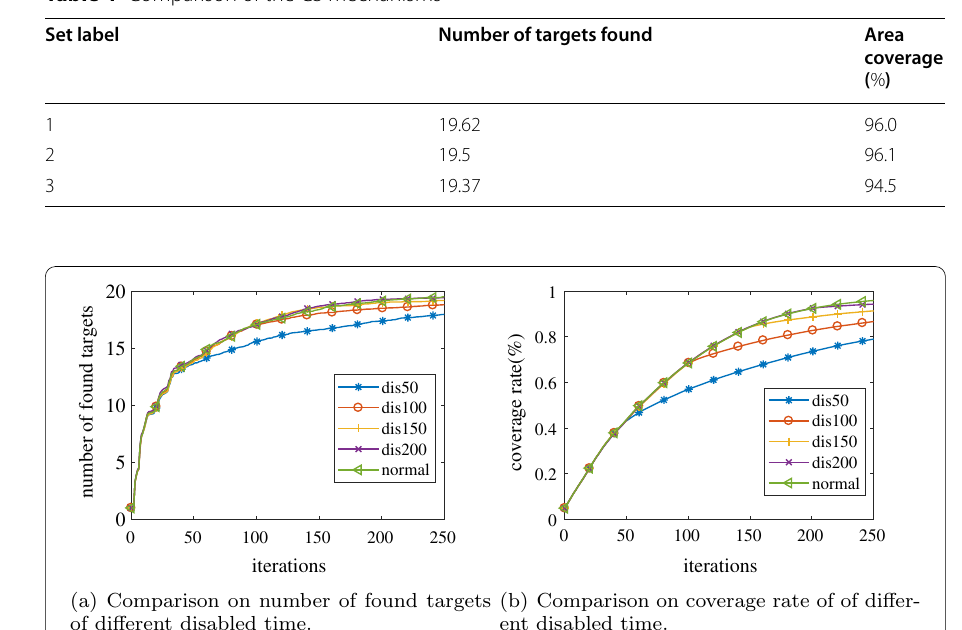
(a) Comparison on number of found targets of different disabled time. Fig. 9 Comparison after 250 iterations for the mission of different disabled